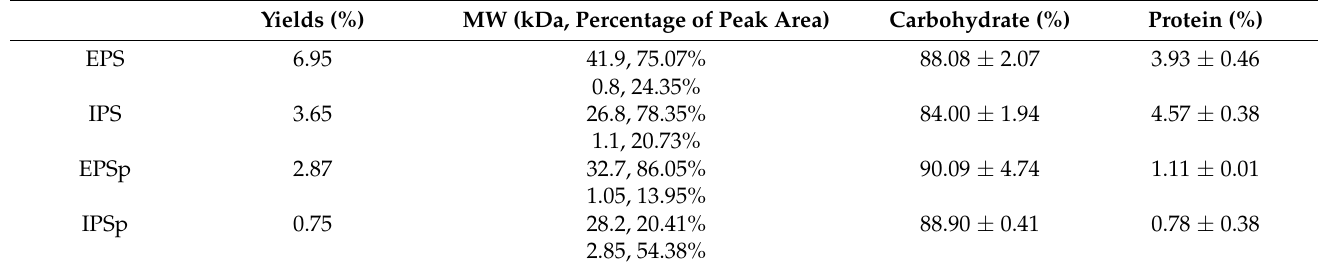
Table 1. Yields and molecular properties of EPS, IPS, EPSp, and IPSp.